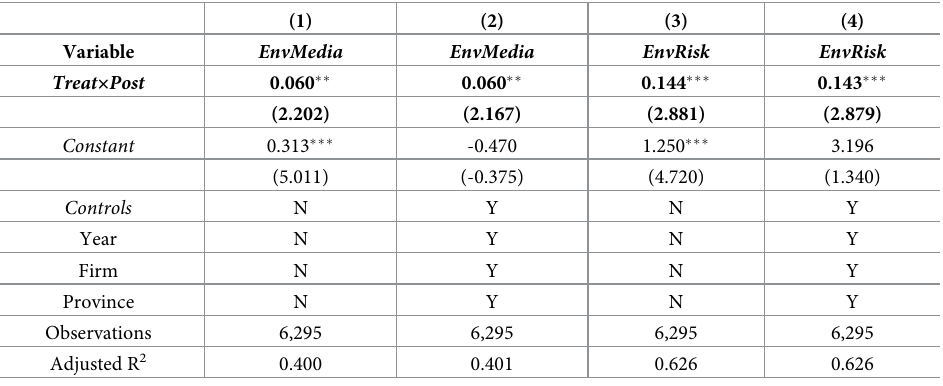
Table 10. Plausible channels: Media attention and perceived environmental